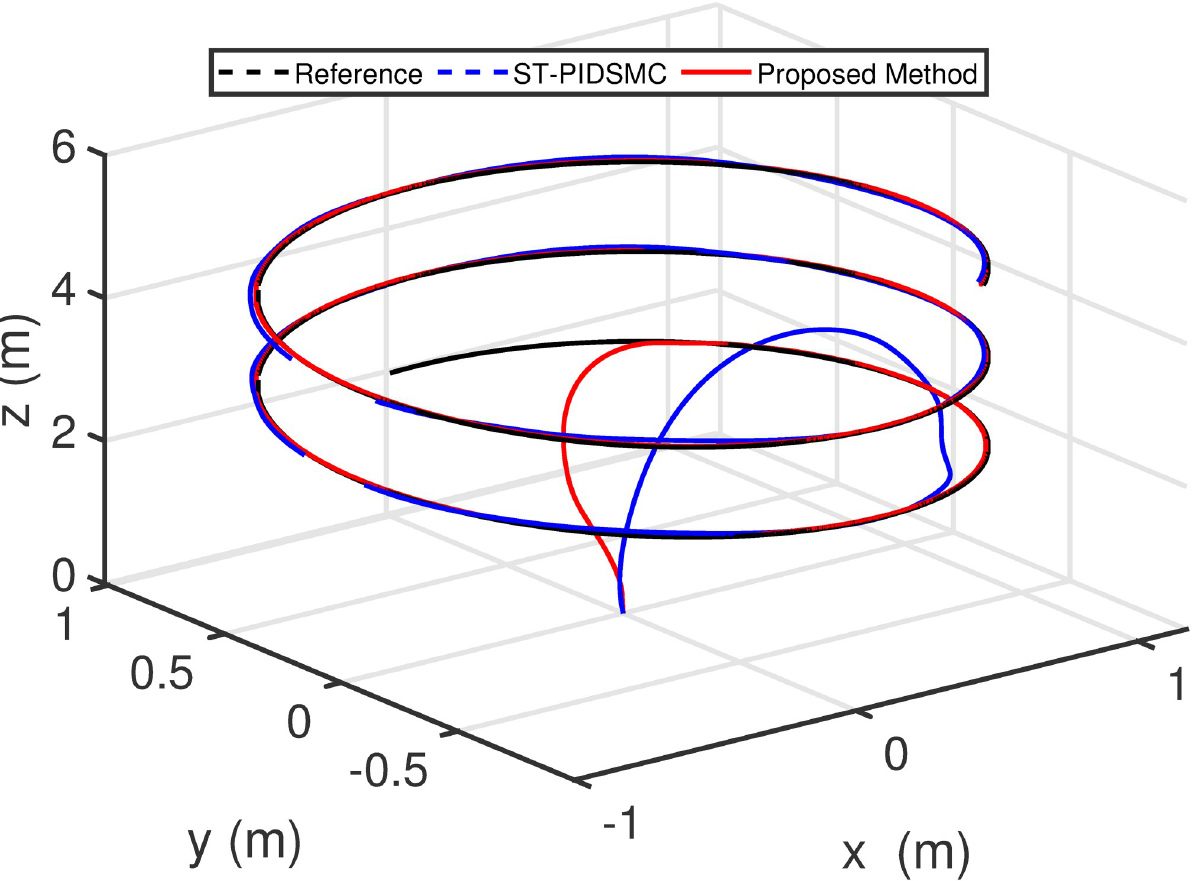
Fig 19. Results of the path following in 2D space under the proposed